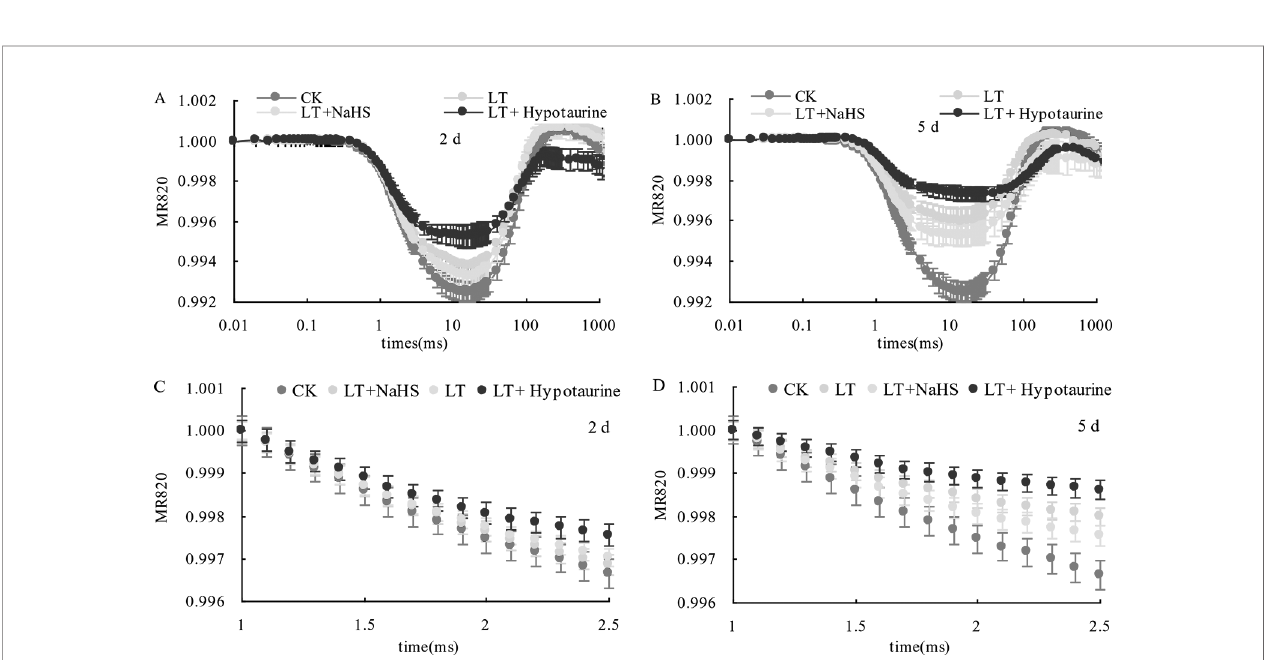
FIGURE 6 | Effects of exogenous NaHS and Hypotaurine on the modulated re fl ected signal of 820 nm (MR820 nm) in blueberry leaves at the 2 nd (A) and 5 th (B) day of low temperature treatment and on the slope of the MR820 nm curve at the initial stage (1 – 2.5 ms) of decline at the 2 nd (C) and 5 th (D) day of treatment. The data in the fi gure are from fi ve replicated experiments (n = 5). CK: room temperature control at 25°C; LT: low temperature treatment; LT + NaHS: low temperature treatment at 4 – 6°C after spraying 0.5 mmol·L – 1 NaHS; LT + Hypotaurine: low temperature treatment at 4 – 6°C after spraying leaves with 200 m mol·L – 1